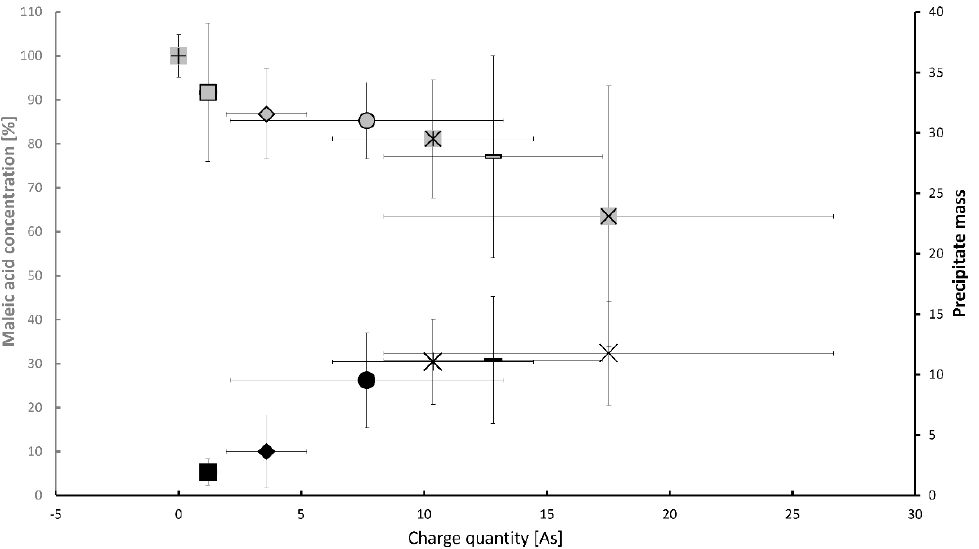
Figure 5. Relative maleic acid degradation and precipitate mass production in relation to the applied charge quantity. Black data points: Precipitate mass after two minutes of BDD application to two milliliters of the CaP precursor solution. Different potentials (rsp. currents) were applied to the electrode. Interestingly there is a purported decrease of precipitation efficiency at charge quantities higher than 15 As. This may indicate a lower efficiency of the electrode itself due to surface reduction, as the precipitate is blocking cathode space. Another possible explanation could be an increase in oxygen production leading to a lower degradation of maleate via reactive oxygen species. Mean concentration of maleic acid (grey symbols) and CaP mass (black symbols) depending on mean charge quantities applied is shown; the data indicate that the amount of maleate degradation is directly correlated with the precipitate formation of calcium phosphate.